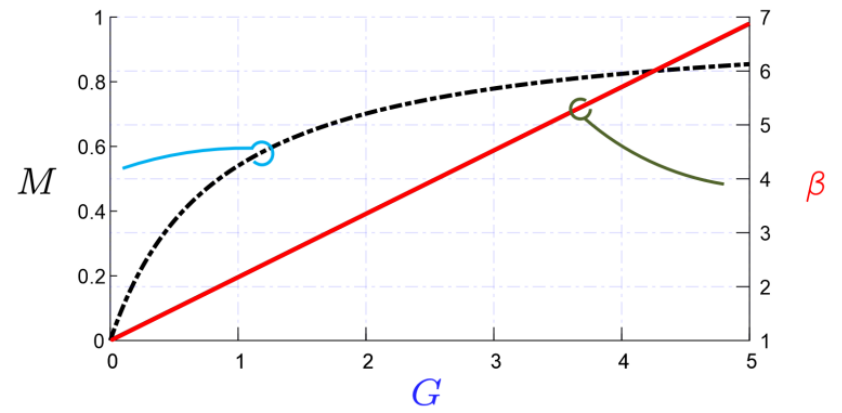
Figure 12. Modulation index and boosting factor versus the AC-gain of the MSVM scheme for the five-phase SSI.